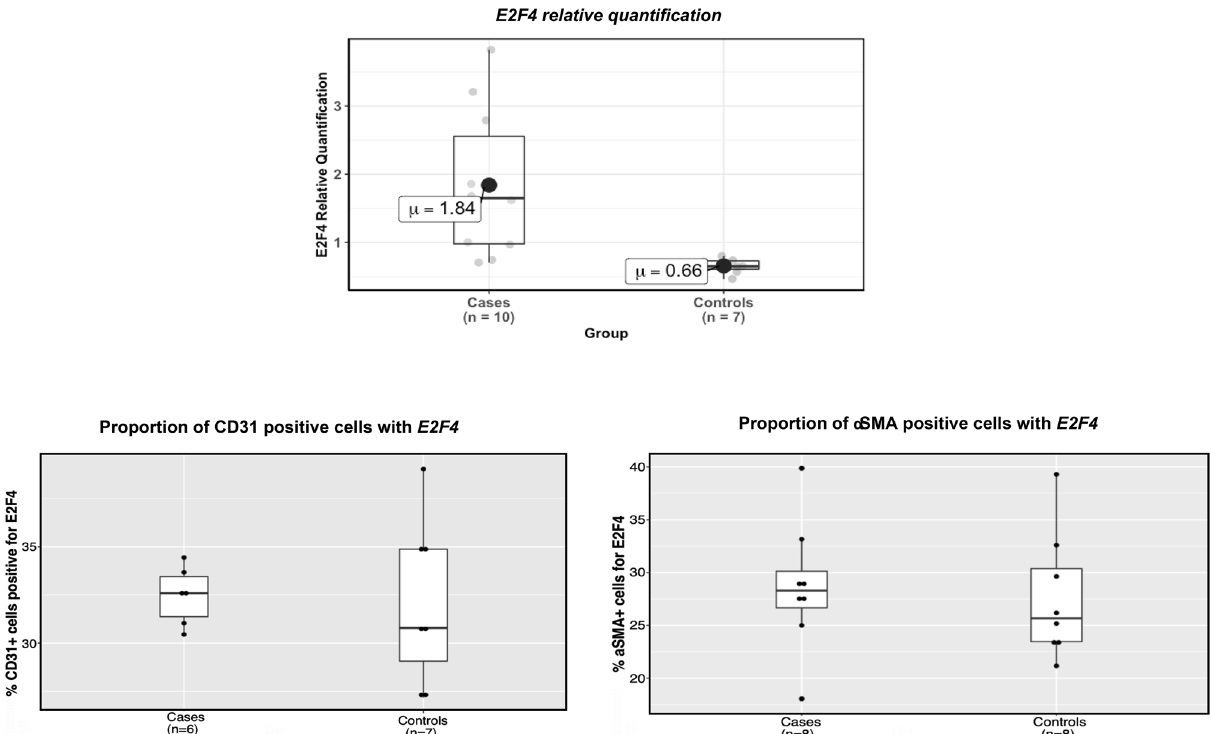
Figure 2. E2F4 expression. ( A ) E2F4 relative quantification box plot for cases and controls from the qRT-PCR experiment. ( B ) Proportion of CD31 positive cells with E2F4 expression. ( C ) Proportion of αSMA positive cells with E2F4